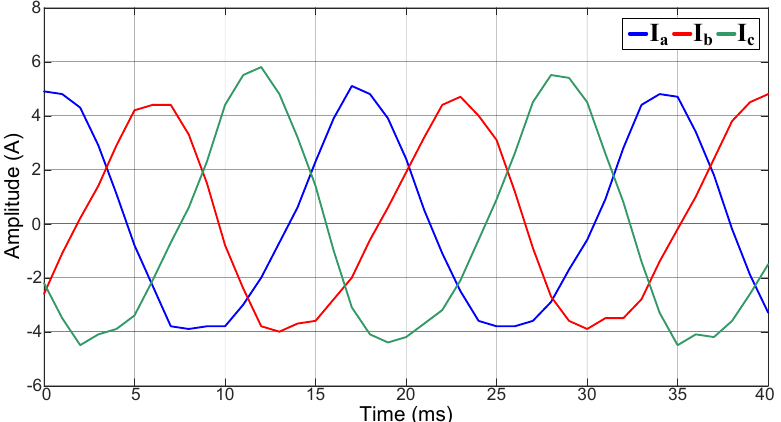
Figure 9. Phase currents from an induction motor with a 5% short-circuit fault condition on phase-C of its stator winding.